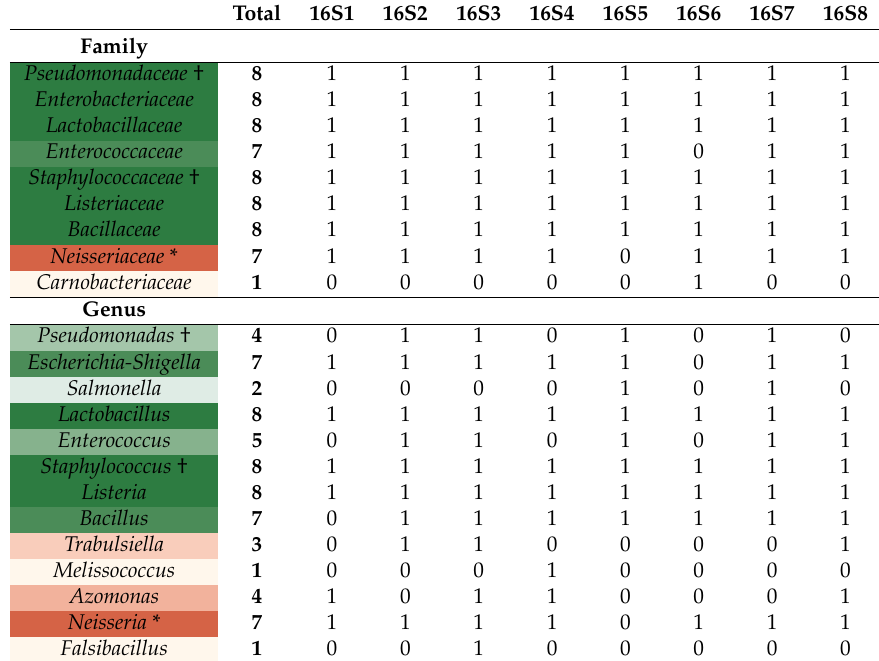
Table 3. Overview of bacteria identified in each gene region for MiSeq data using the SILVA database at different taxonomic levels. The first column lists the identification at the taxonomic level considered. The second column lists the total number of gene regions where the bacterium was identified. The next columns list the different samples (0 = not detected/1 = detected). Taxonomic names are colored per taxonomic level by a green gradient for bacteria present in the mock community (darker = correctly identified in more samples), and an orange gradient for bacteria not present in the mock community (darker = incorrectly identified in more samples).